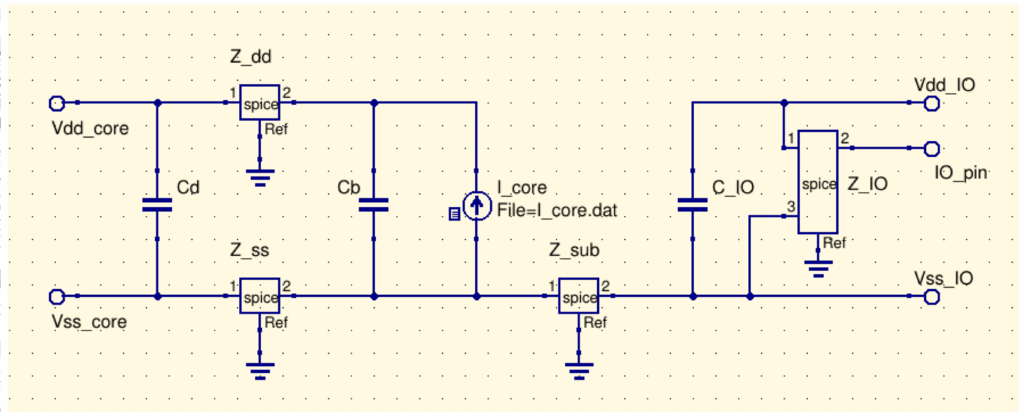
Figure 2. The proposed ICEM model, to describe the internal activity (the core and the I/O